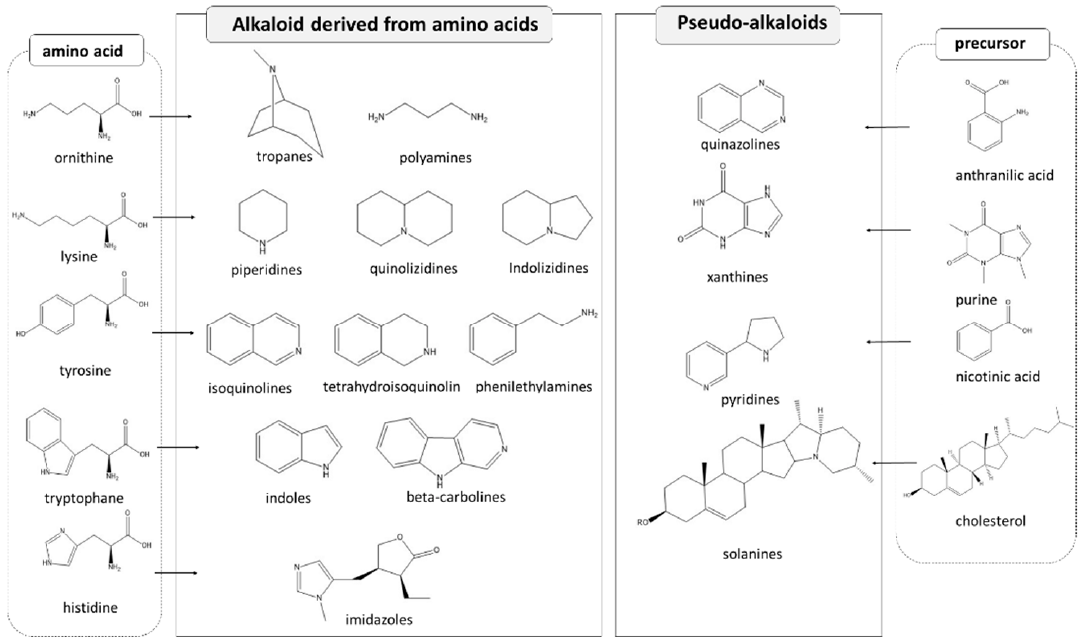
Figure 4. Examples of alkaloids (basic skeletons) and their precursors.